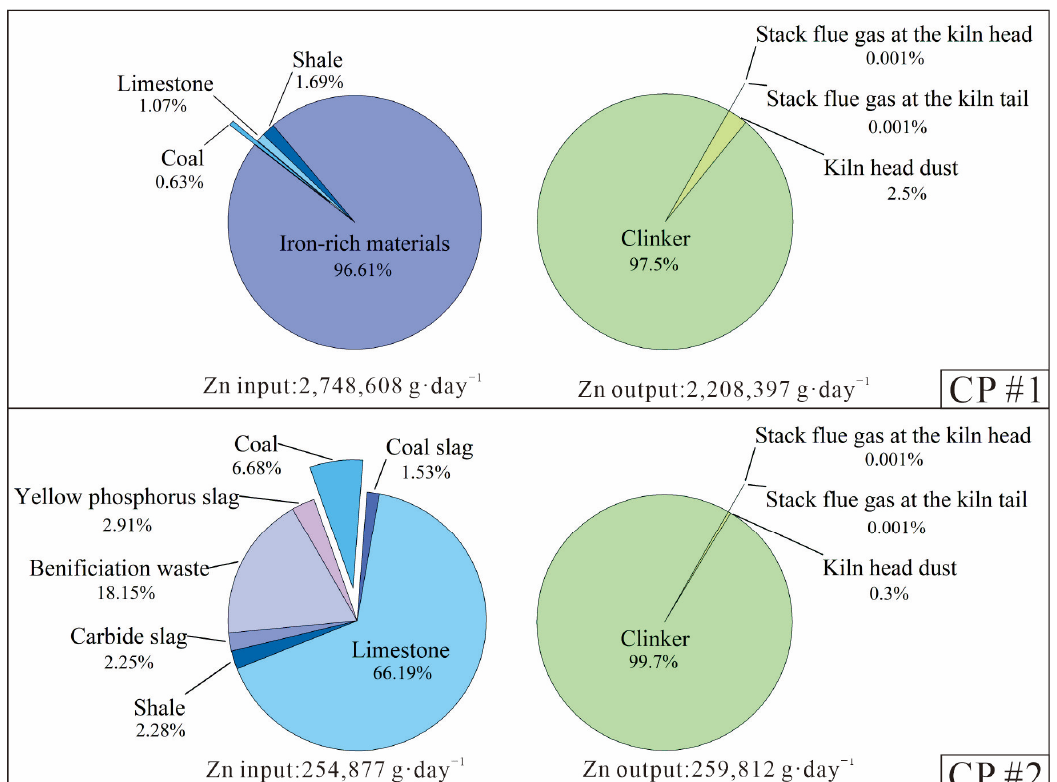
Figure 2. Breakdown of the daily input and output of Zn during the clinker production process of the two CPs.